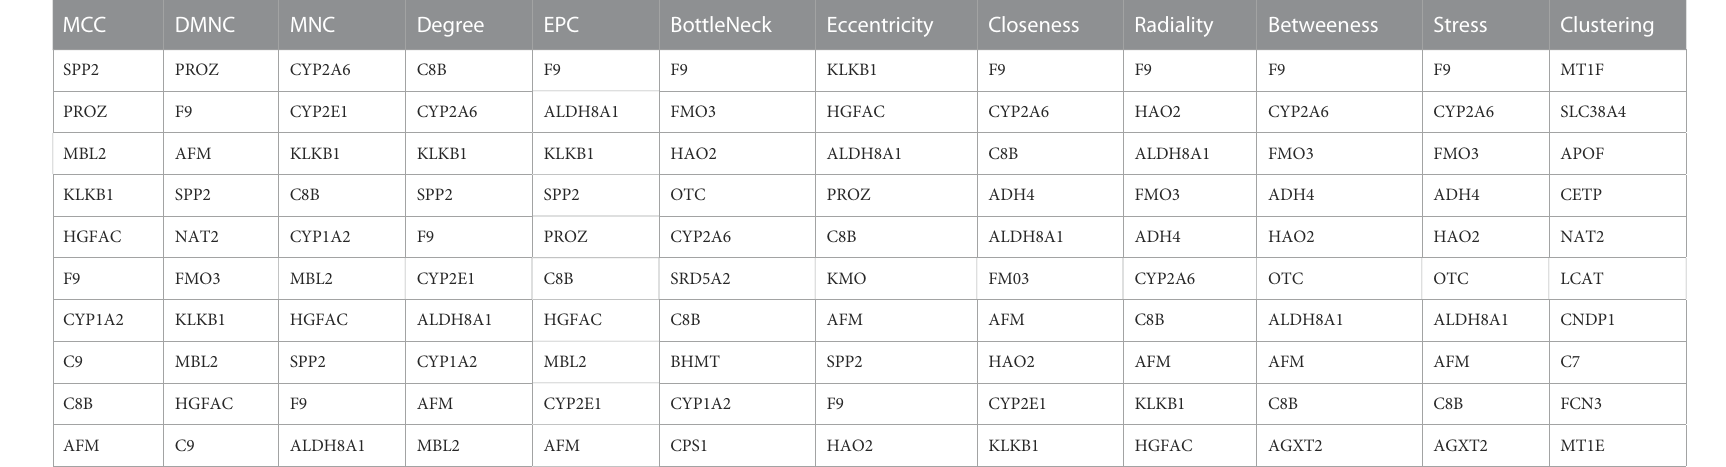
TABLE 2 Top 10 down-regulated DEGs by using 12 topological analysis methods of CytoHubba. MCC BottleNeck Eccentricity Closeness Radiality Betweeness Stress